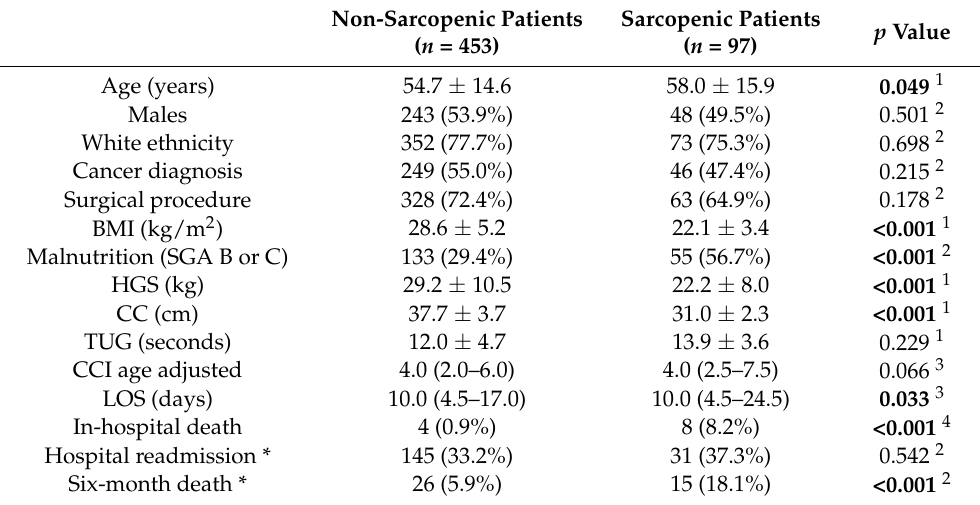
Table 1. General and clinical outcomes comparison of patients grouped according to sarcopenia diagnosis.